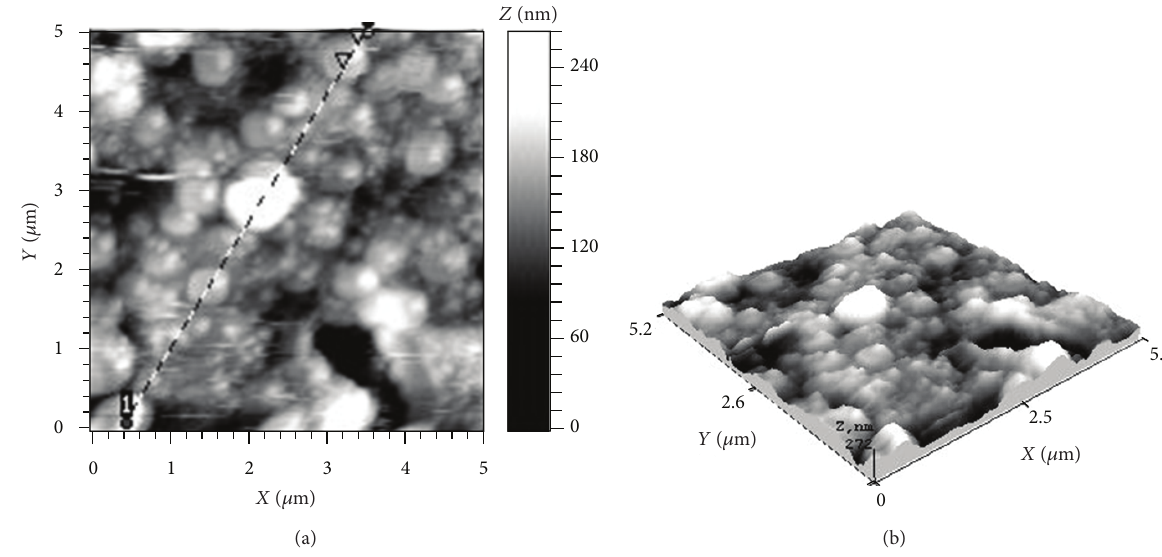
F 3: AFM image of Ag S layer on etched PP surface immersed for 5 times in 2